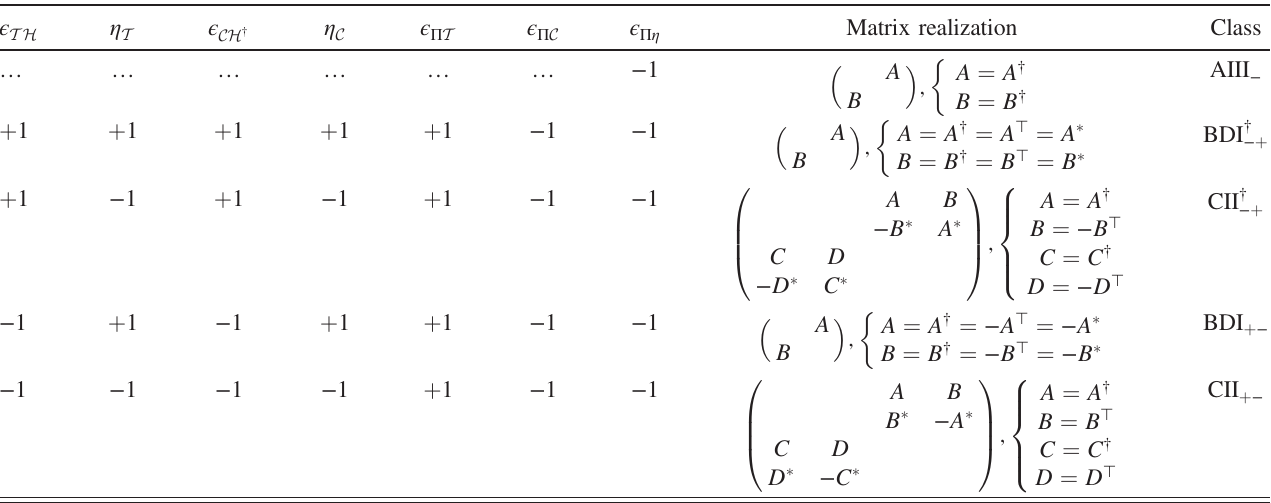
TABLE IV. Five non-Hermitian symmetry classes with reality conditions realized in the nHWSYK model. For each class, we list its antiunitary and chiral symmetries and their commutation relations, an explicit matrix realization [92], and its name under the Kawabata- Shiozaki-Ueda-Sato classification [66]. The symbols ϵ XY indicate whether the two operators X and Y commute, e.g., T HT − 1 ¼ ϵ T H H , while the symbols η X denote the square of operator X , e.g., T 2 ¼ η T . In the matrix realizations, A , B , C , and D are arbitrary non- Hermitian matrices unless specified otherwise, and empty entries correspond to